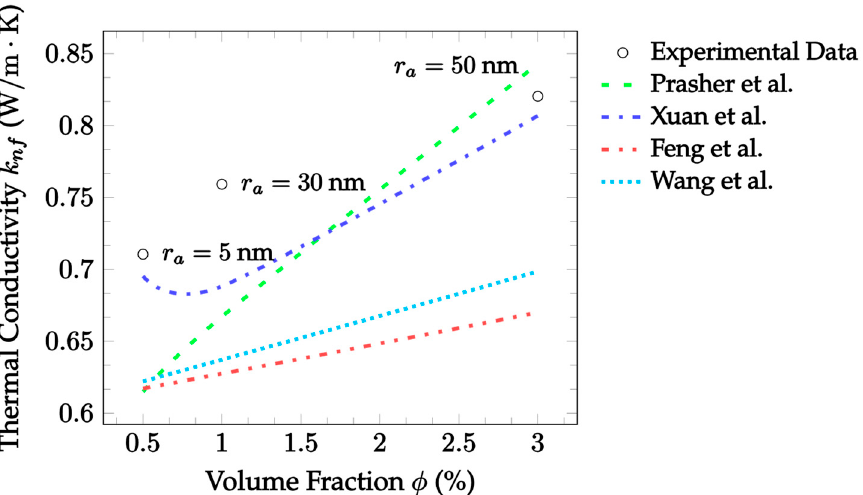
Figure 9. Aggregation model thermal conductivity predictions compared with data for Fe 3 O 4 –water nanofluid: Experimental Data [74], Prasher et al. [29], Xuan et al. [30], Feng et al. [31], Wang et al. [32].